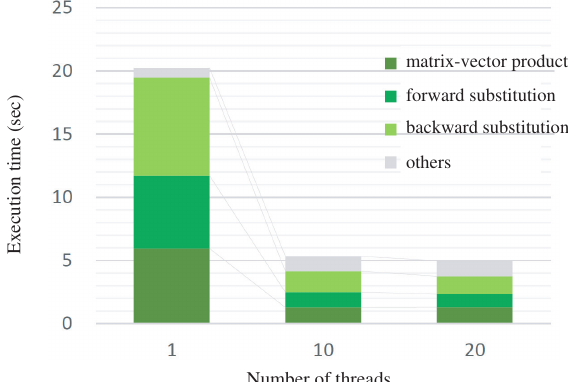
Figure 14. Breakdown of the execution time for the 51 × 51 × 52 mesh.